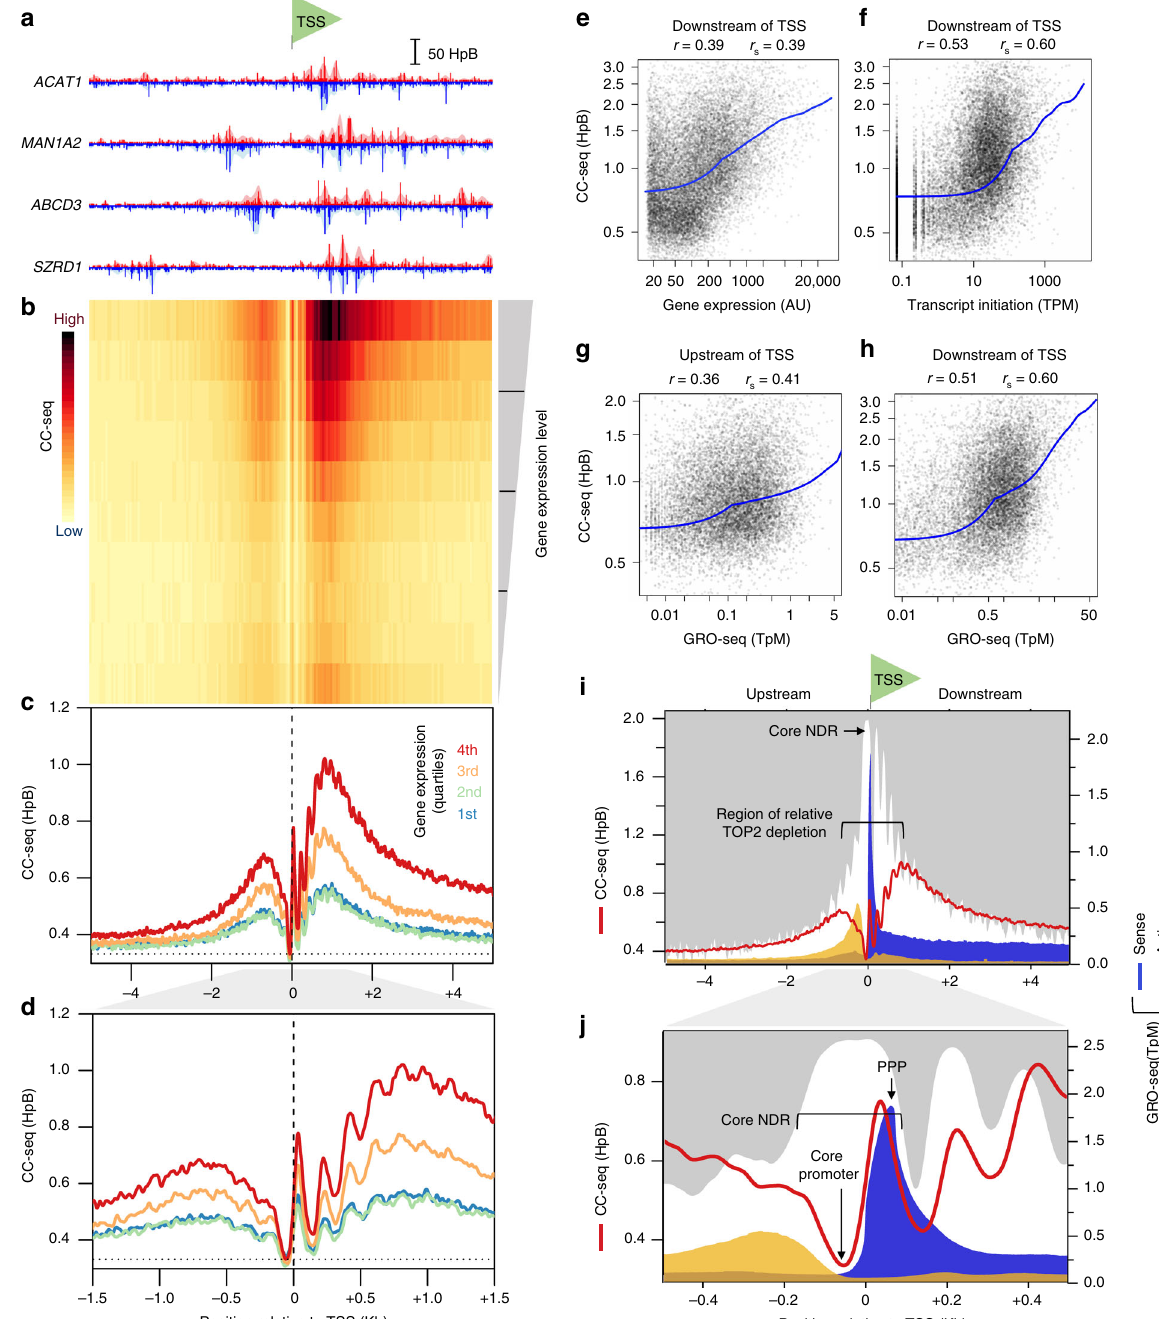
Fig. 5 TSS-proximal TOP2 activity is strongly correlated with gene transcription. a – d Aggregation of TOP2 CCs in a 10 Kbp window centred on orientated TSSs in human RPE-1 cells. Four example TSSs are shown orientated in the 5 ′ – 3 ′ direction ( a ). A heatmap of all TSSs in the human genome, with 10 aggregated rows strati fi ed by RPE-1 gene expression level 48 . The colour scale indicates average TOP2 CC density in each 50 bp bin ( b ). Motifs are also strati fi ed into 4 quartiles of gene expression, and the average TOP2 CC distribution in each quartile plotted at two levels of zoom. Horizontal line is the genome mean. Vertical line is the TSS ( c – d ). e – h Quantitative correlation between CC-seq signal and transcription rate. Scatterplot of CC-seq (5 Kbp window downstream of TSS) and gene expression ( e ), or transcription initiation 49 ( f ). Scatterplot of CC-seq signal in 5 kb windows directly upstream and downstream of TSS and GRO-seq in 200 bp regions directly upstream and downstream of TSS. Blue line = lowess curve. Pearson r and Spearman r s values were calculated between CC-seq and log-transformed measures of transcription rate. i – j Aggregate comparison of CC-seq (red line), nucleosome occupancy 71 (grey shading), and strand-speci fi c GRO-seq 50 centred on TSS at two levels of zoom. MNase-seq data is inverted to emphasise spatial relationship between CC-seq and nucleosome depletion (white). PPP promoter proximal transcriptional pausing, TpM Transcripts per million mapped reads per base pair, HpB Hits per billion mapped reads per base pair, AU arbitrary